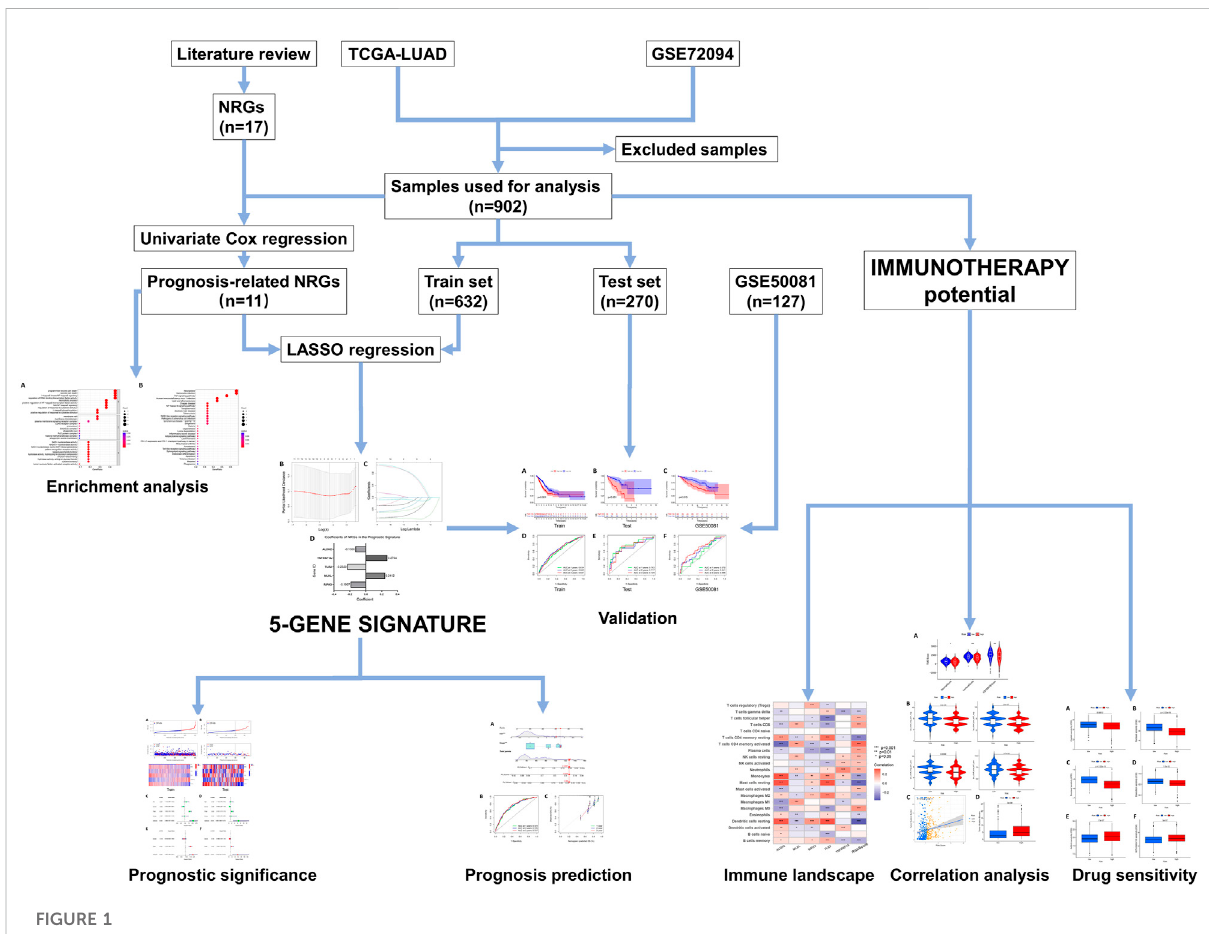
FIGURE 1 The framework and work fl ow of this